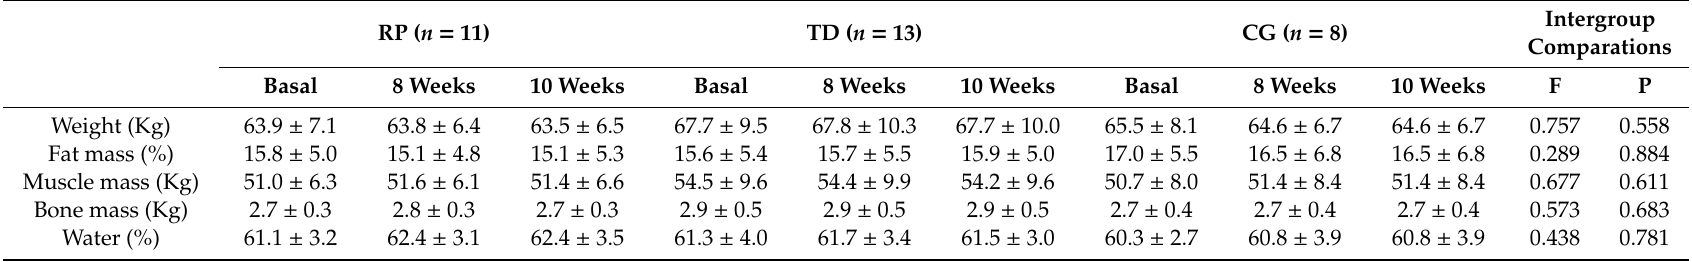
Table 2. Data of body composition test before, after 8 weeks of training, and after two weeks of tapering in the three groups, mean ± SD.